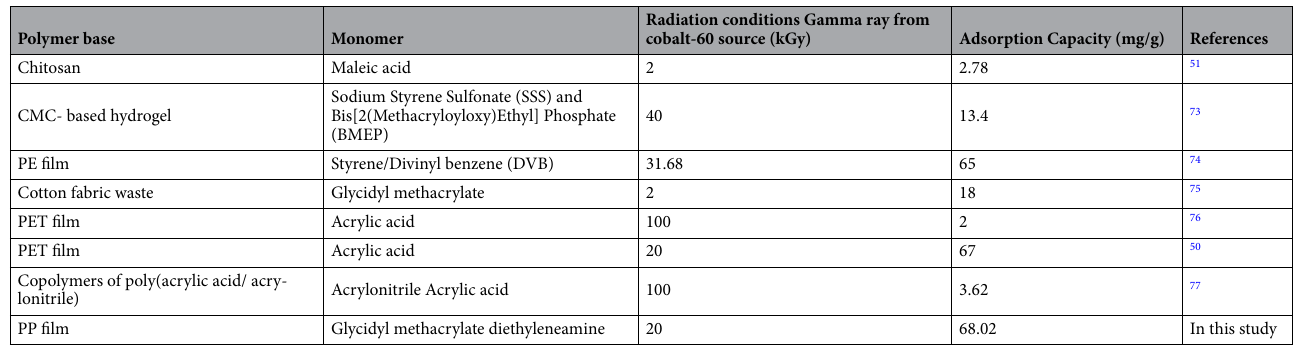
Table 8. Comparison of experimental data with other research works in the